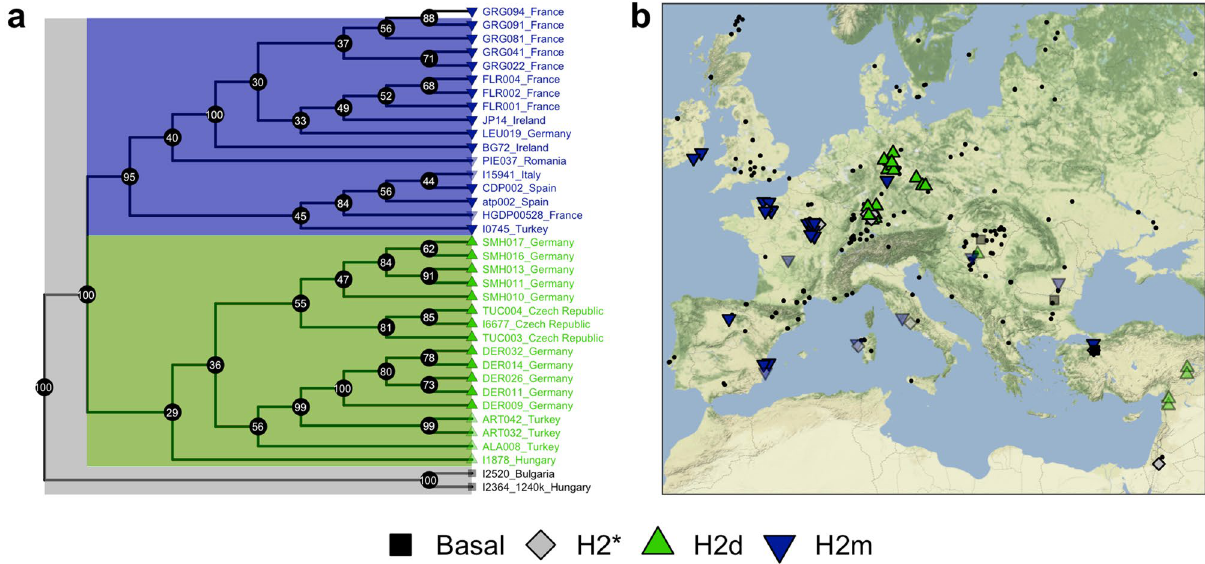
Figure 3. ( a ) Phylogenetic relationships (no branch length units) and ( b ) H2 sample locations (map created using ggmap, Kahle and Wickham 2013). Shapes and colours indicate the two major clades inferred from the phylogenetic tree. Symbol shading indicates early to late Neolithic (solid) or post-Neolithic (transparent). Black dots indicate all non-H2 Neolithic individuals from Freeman2020 to indicate H2 sampling prevalence 53 . Stars in haplogroup assignments in ( a ) indicate a lack of resolution to assign samples (not used in the ML tree) to downstream